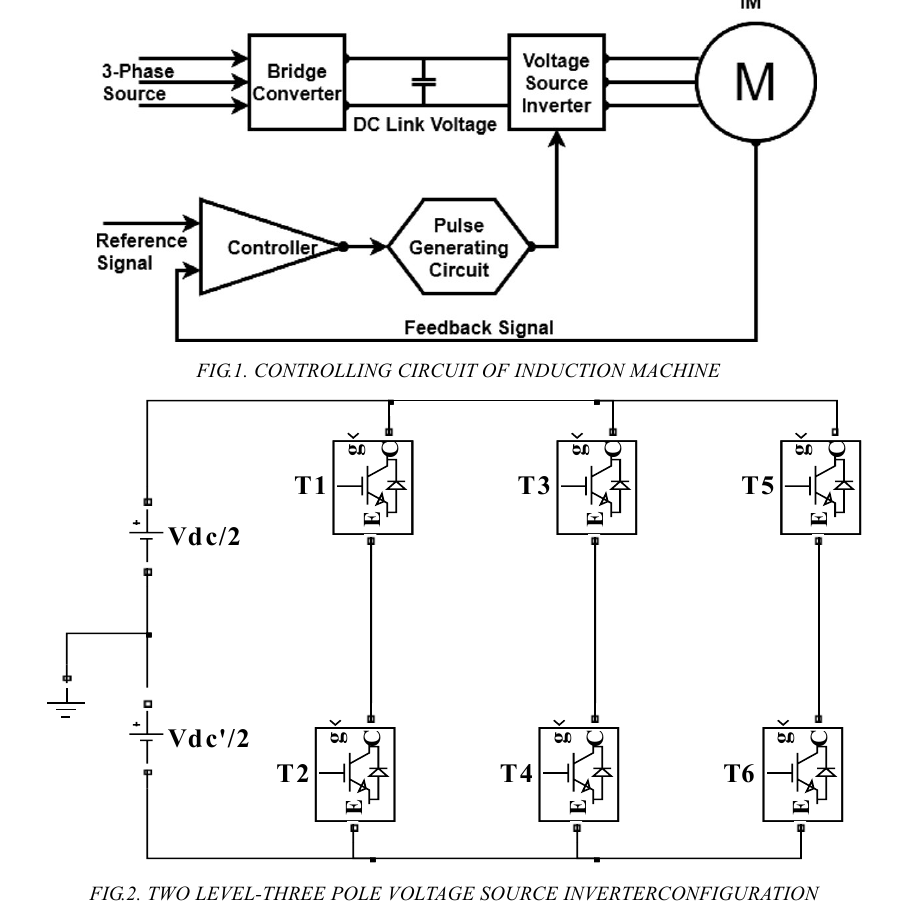
FIG.2. TWO LEVEL-THREE POLE VOLTAGE SOURCE